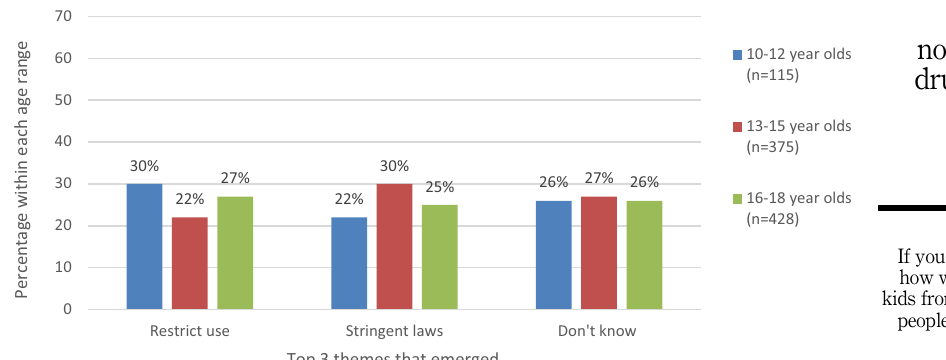
Figure 3. If you ran the world,